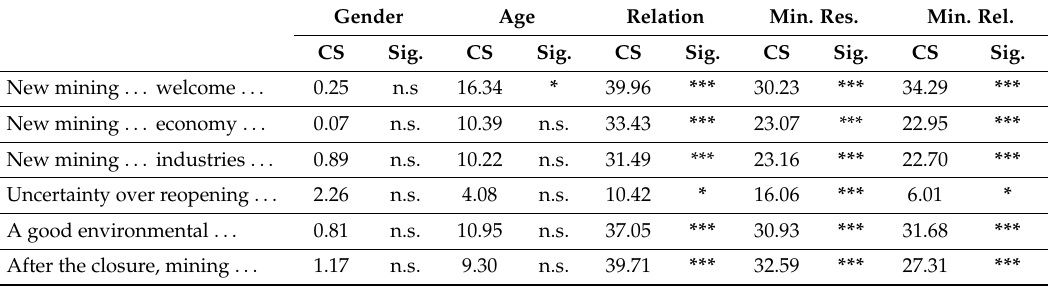
After the closure, mining . . .